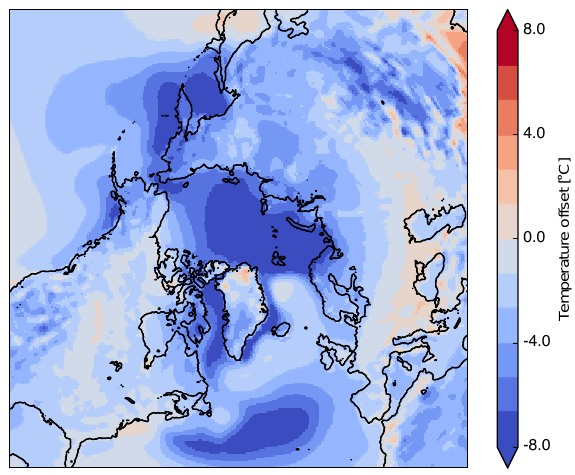
Figure 3. Difference between the CCSM4 PD and ERA-Interim temperature (CCSM4 PD − ERA-Interim) interpolated onto the ice sheet model grid. A general cold bias with an average of − 3.0 ◦ C is observed over the full domain. Largest offsets are found in regions with excessive sea ice in the model as well as in the path of the North Atlantic